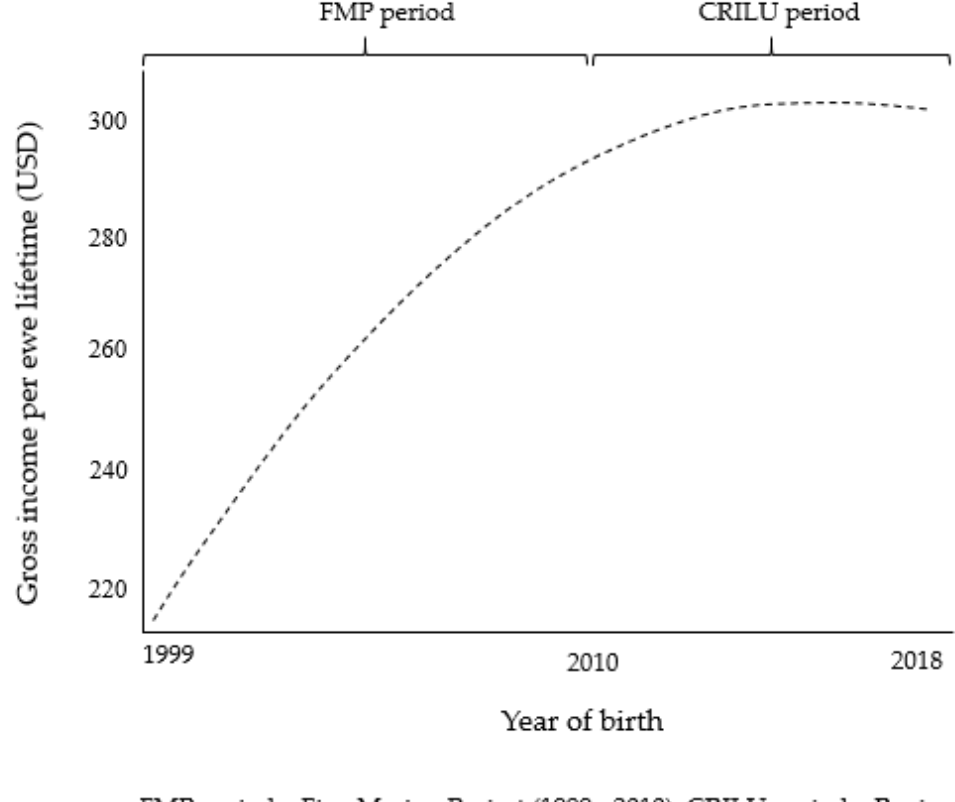
Figure 7. Gross income per ewe lifetime (across four lambing opportunities) per year of birth (1999– 2018) in the nucleus flock. Total wool production and total lamb live weight at weaning across four lambing opportunities were assumed constant across years. It was assumed that all lambs were sold at weaning. Average wool and meat prices were calculated for the period 2013–2019 [3,35] and utilized for the entire analysis period (1999–2018).